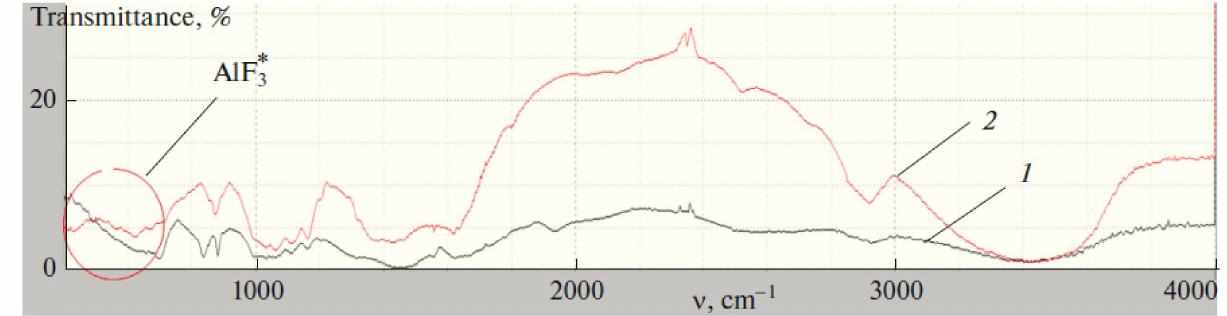
Figure 12. Change in IR spectrum during sorption of fluoride ions: (1) IR spectrum of original sorbent, and (2) after